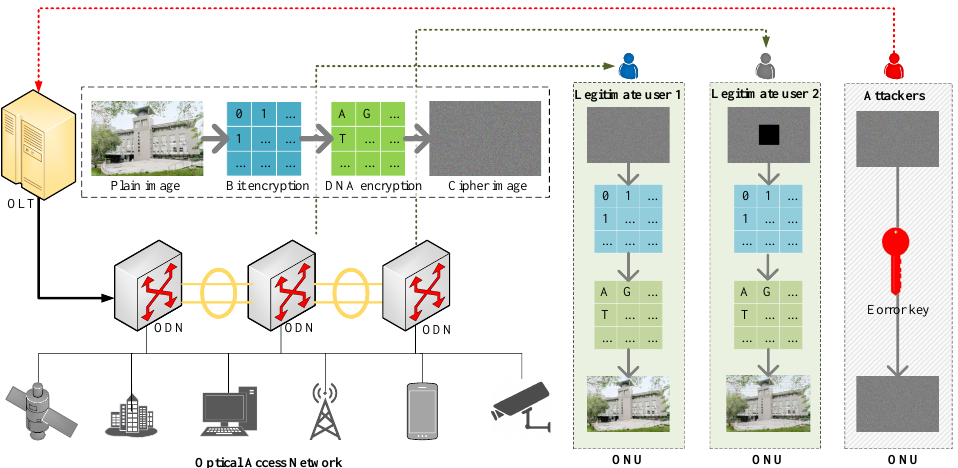
Figure 6. A diagram of the image cryptosystem used in Optical Access Network secure